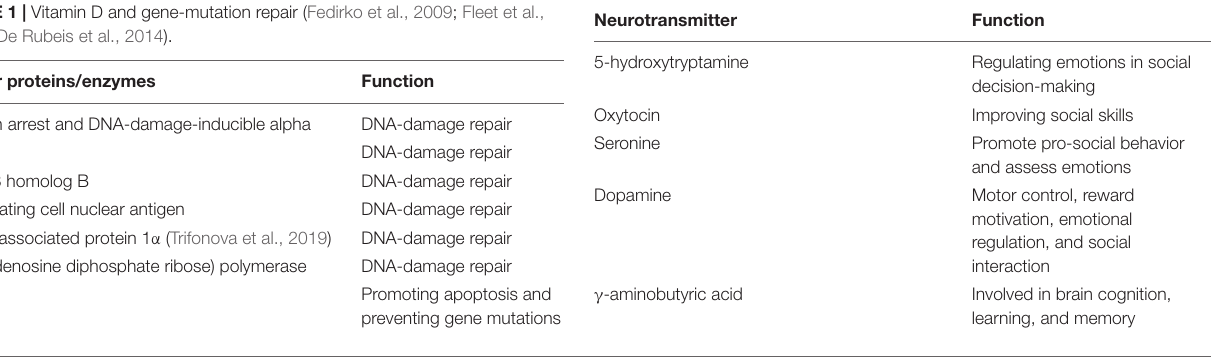
TABLE 2 | Vitamin D–associated neurotransmitters (Staal et al., 2012; Patrick and Ames, 2014; Pertile et al.,